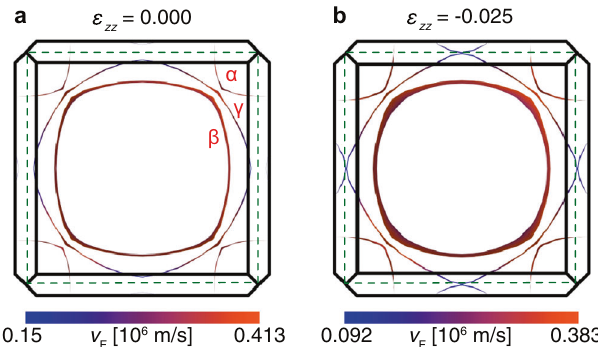
Fig. 6 | DFT Fermisurfaces under c -axiscompression. Fermisurfacesof Sr 2 RuO 4 projected along k z under( a ) zerostress and ( b ) ε zz = − 0.025.Thewidth of the lines indicatesthewarpingoftheFermisurfacealong k z .Thedashedgreenlineisthe2D zone boundary of the RuO 2